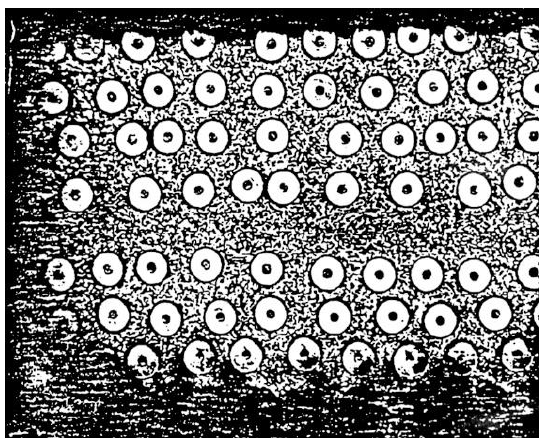
Figure 1. Transverse cross-section of a SiC/Ti-15-3 composite.